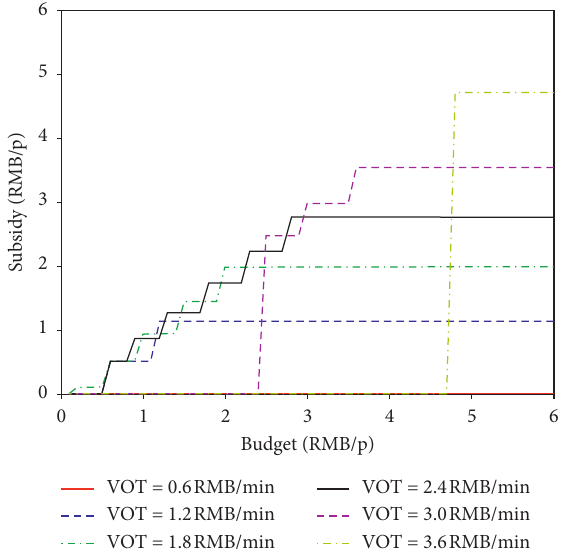
Figure 10: Variation of optimal subsidies with the